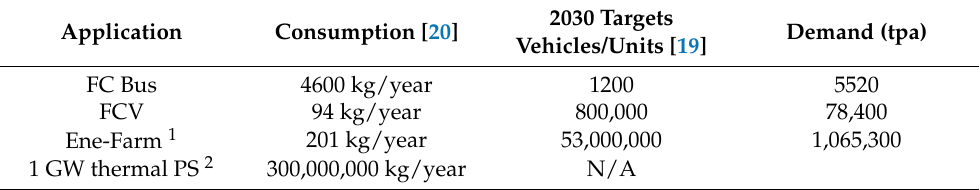
Table 1. Estimated potential demand for hydrogen for selected fuel cell